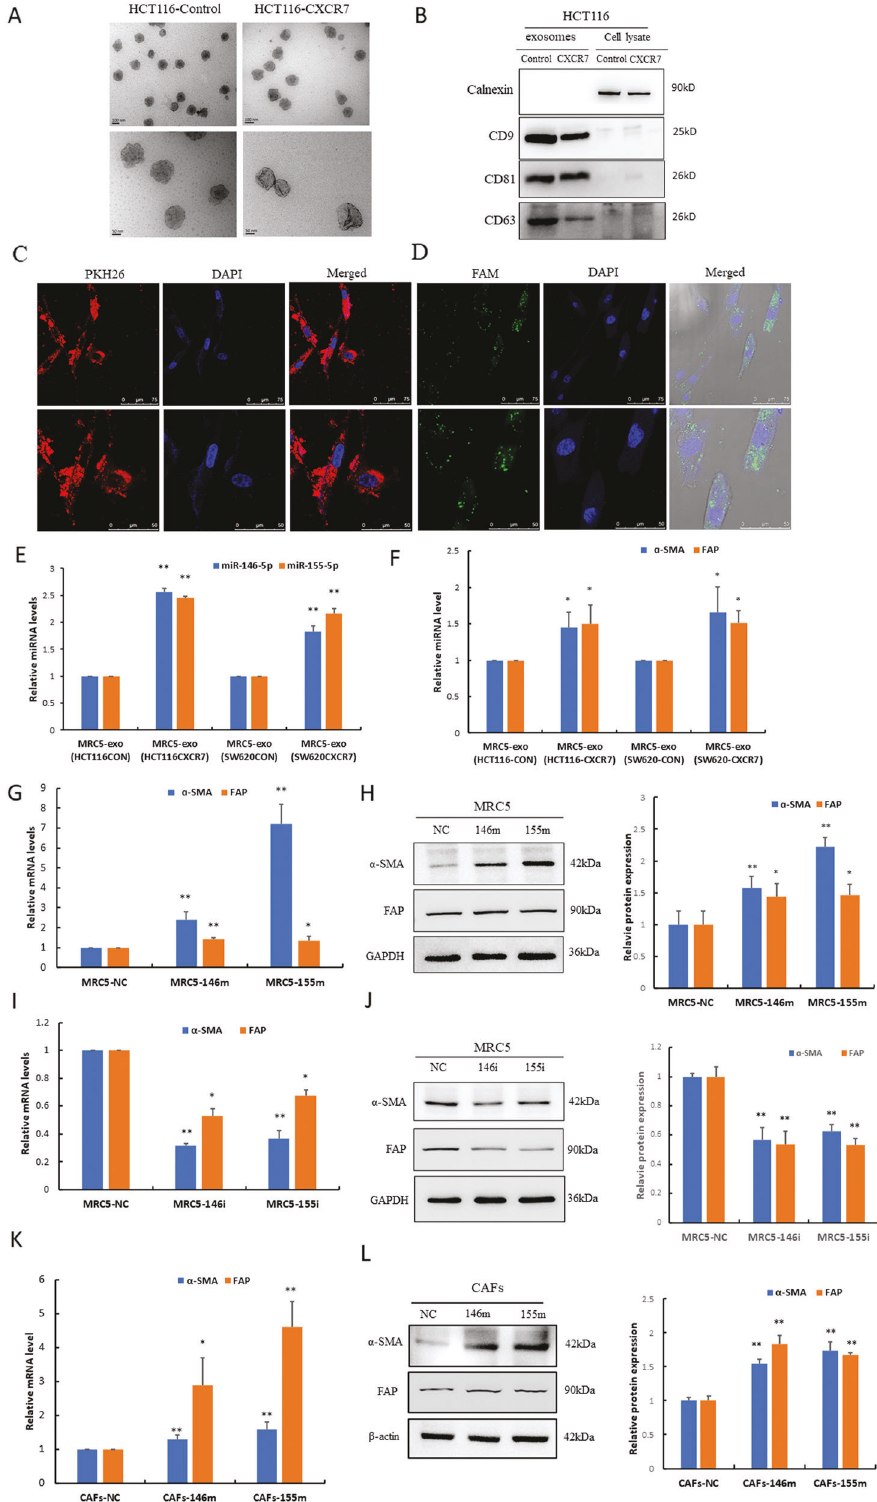
FC3 system (ProteinSimple, USA) by chemiluminescence (Millipore, USA) and quanti fi ed by densitometry using AlphaView software. Densitometric analyses of the bands were normalized with β -actin or GAPDH that function as loading controls.